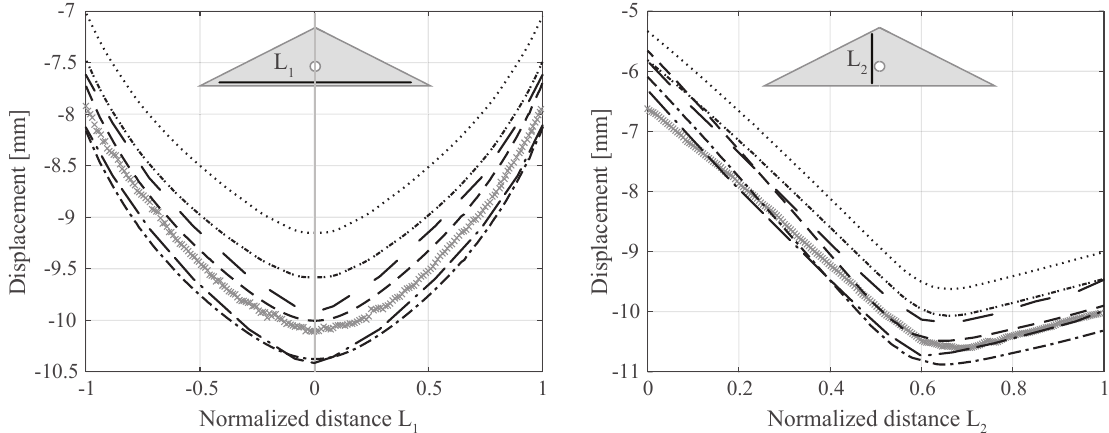
Figure 18. Comparison of experimental and numerically obtained results for 25 kN total load, which approximately corresponds to the occurrence of SLS maximal allowed displacements. Vertical displacements profile along the length of the marked lines L 1 and L 2 . For the graph legend, refer to Figure